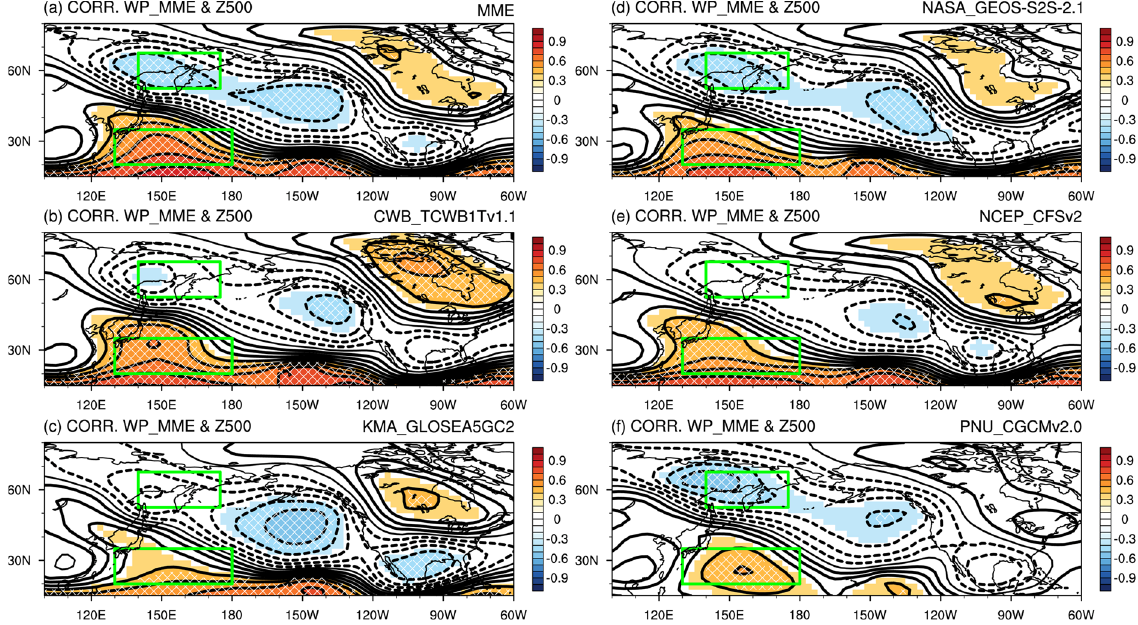
Figure 4. Correlation patterns between Z500 and the WP index predicted by the ( a ) MME and ( b – f ) individual models for the entire series. Green boxes enclose the areas of Z500 averaging used for the estimation of the WP index. Significant at the 99% (95%) confidence level values are shown by hatch pattern (shading).